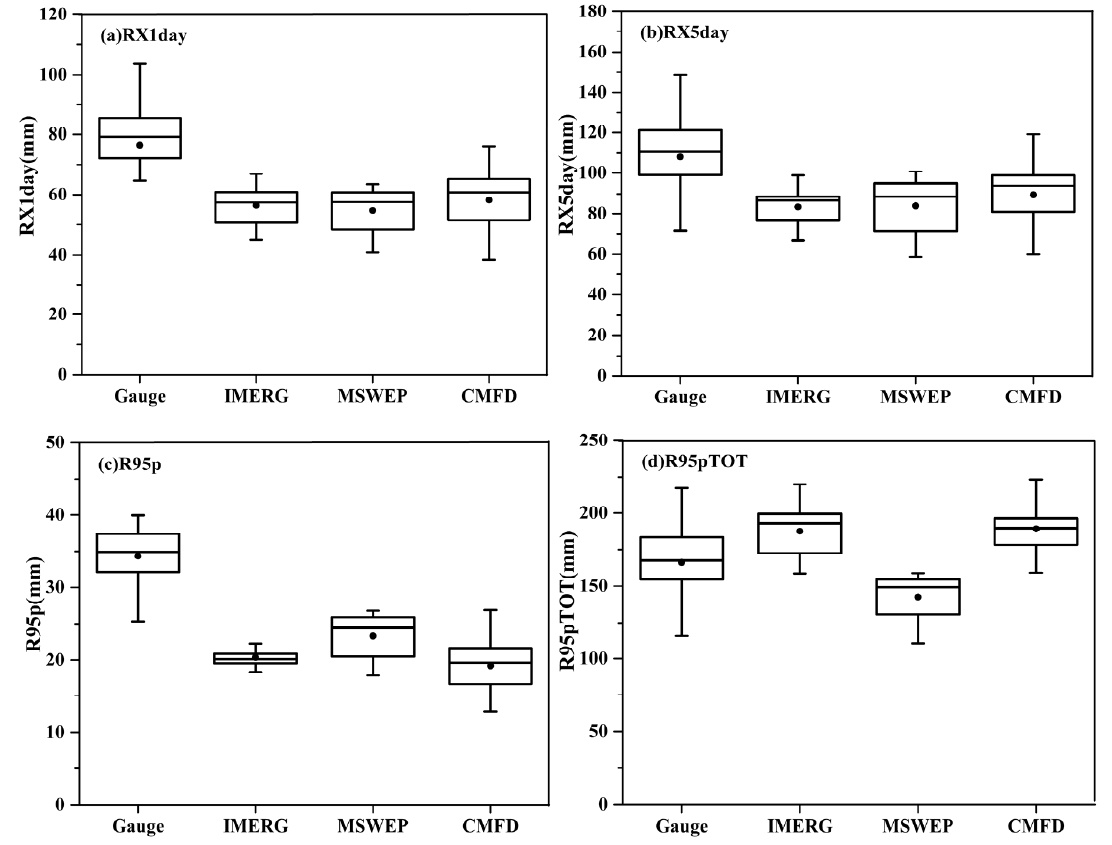
Figure 4. Extreme precipitation index values of the rainfall station data and satellite-derived pre- cipitation data during 2001–2016: ( a ) RX1day, ( b ) RX5day, ( c ) R95p, and ( d ) R95pTOT.